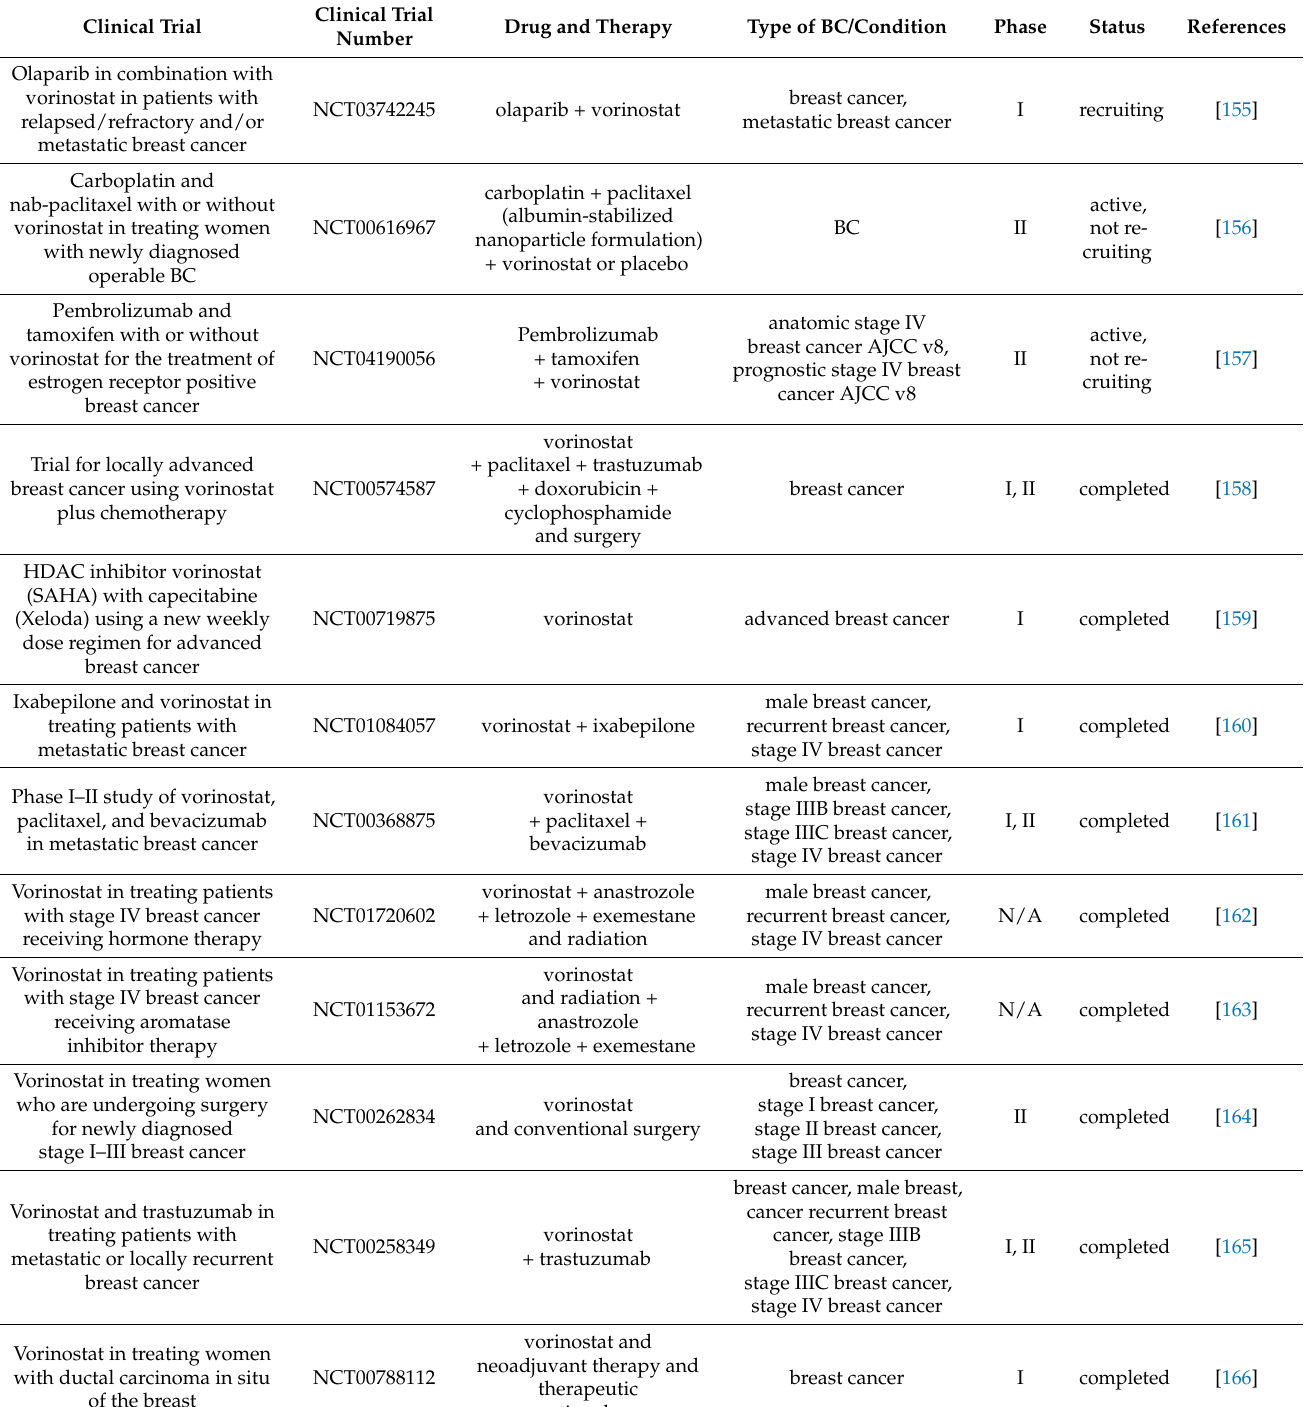
Table 4. Vorinostat (SAHA) in clinical trials (N/A—not